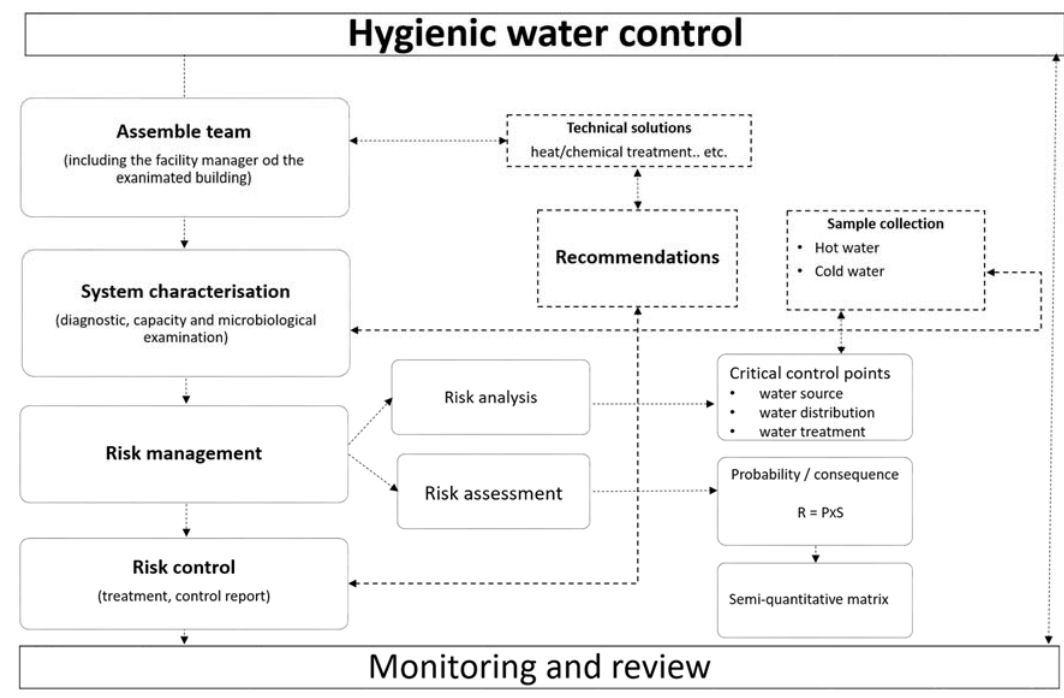
Figure 1. Flow diagram of water control